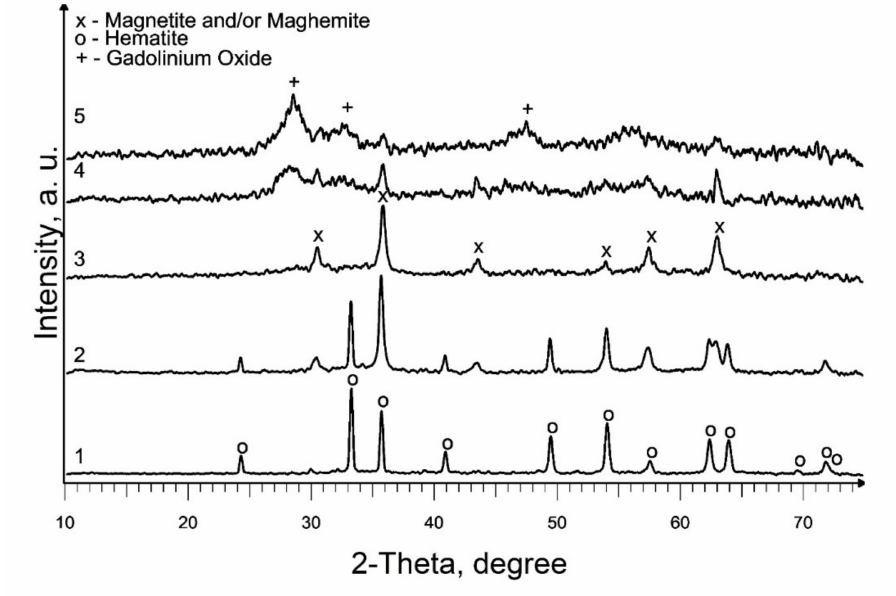
Figure 3. XRD patterns of produced Gd-containing iron oxides samples: 1—S5; 2—S6; 3—S7; 4—S8; 5—S9.